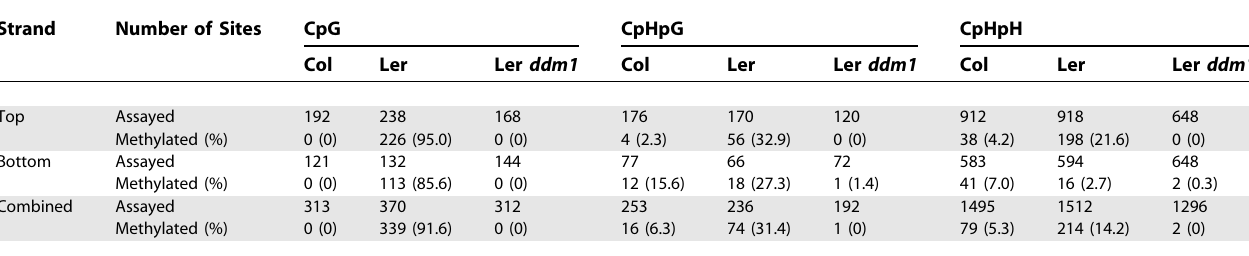
Table 2. Number of Cytosines Methylated at the At2g10410 Locus in Col, Ler, and Ler ddm1–2